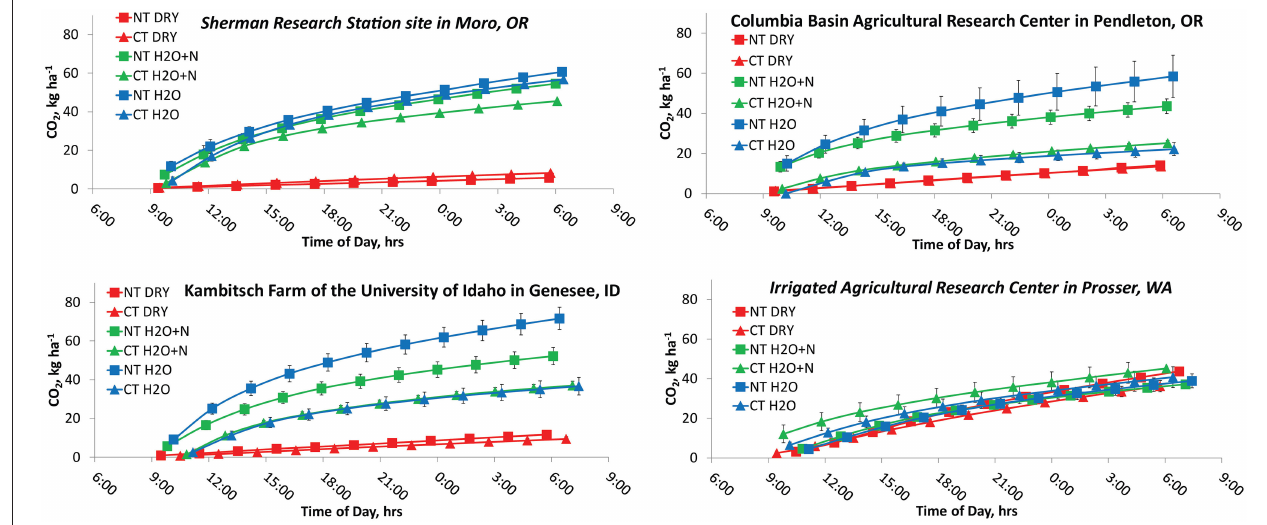
FIGURE 5 | Cumulative emissions of CO 2 during the first day (0–22h) of measurements with and without additions of 150kg N ha − 1 and water to no-tillage and conventional tillage management systems.